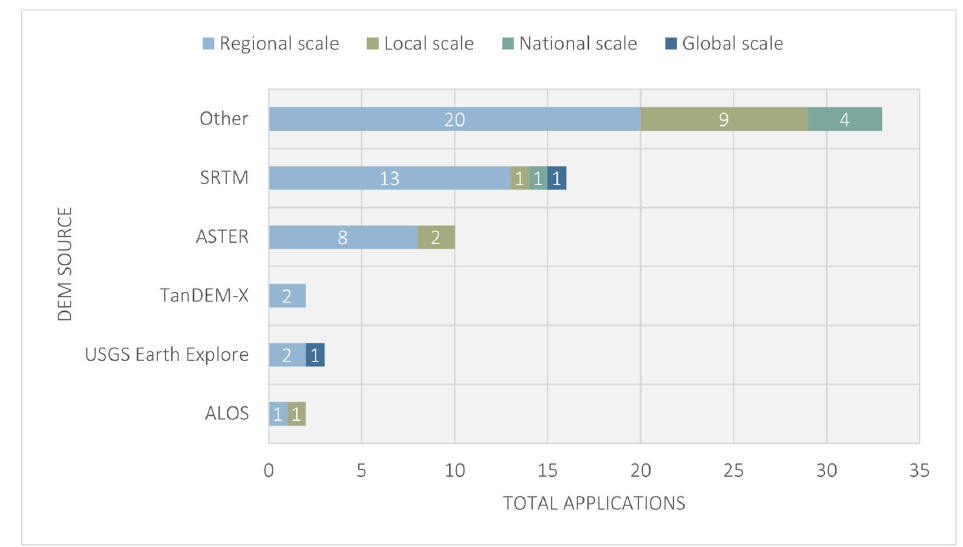
Figure 4. DEM sources and scales of applications.